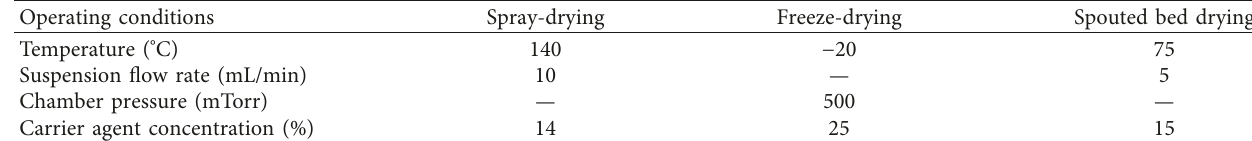
Table 1: Conditions used to produce ACMP by different drying